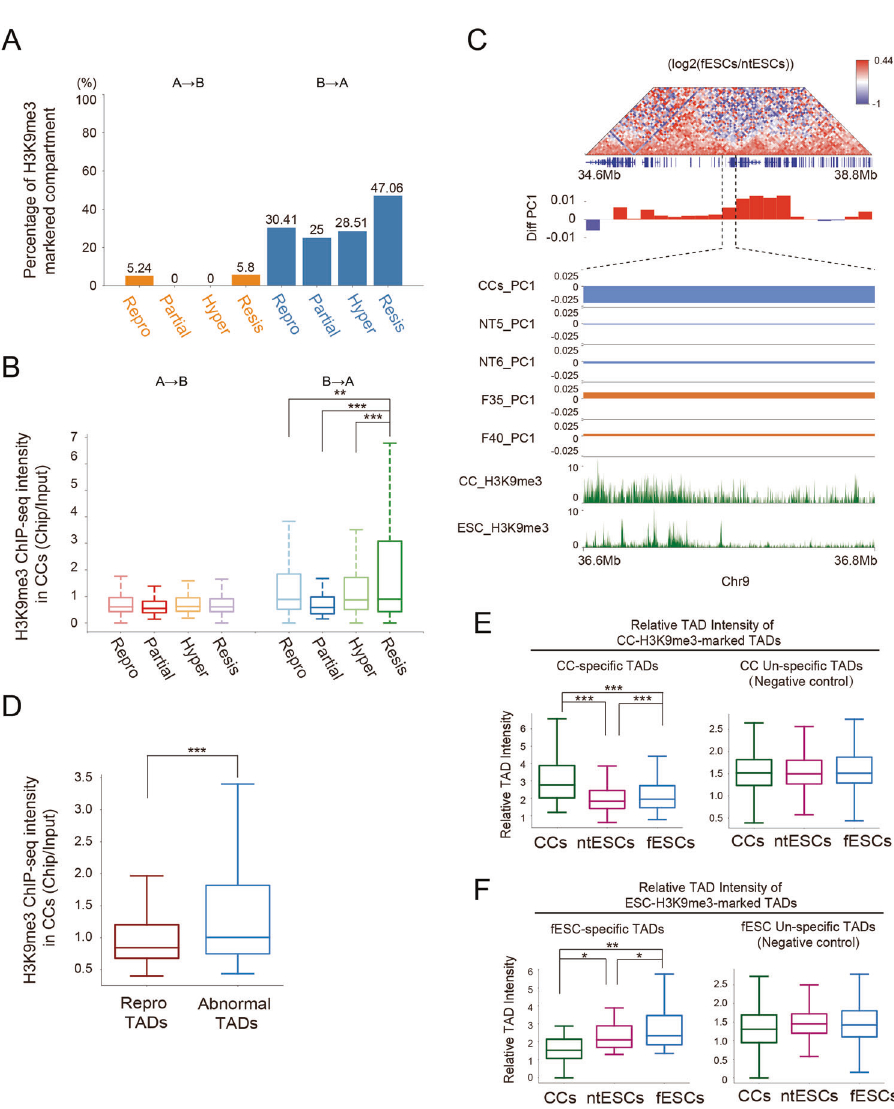
Fig. 6 H3K9me3 in Abnormal chromatin structures in ntESCs. A The bar chart showing the proportion of the H3K9me3-marked compartments in each group in Fig. 4A. B Boxplot showing the average H3K9me3 Chip-seq intensity (Chip/Input) in CCs for each group of compartment dynamics (200 Kb resolution). C The differential interaction frequencies (log2(fESCs/ntESCs)) and corresponding H3K9me3 signals around a B-to-A resistant compartment region. The bottom tracks show the H3K9me3 signals in CCs [18] and ESC [58] respectively within a B-to-A resistant region (Chr9: 36.6 Mb – 36.8 Mb). D Boxplot showing the average Chip-seq intensity (Chip/Input) of H3K9me3 in CCs for the ‘ Repro ’ and ‘ Abnormal ’ TADs (including ‘ Resis ’ and ‘ Hyper ’ ). E Boxplot showing the average relative TAD intensity (RTI) of the H3K9me3-marked CC-speci fi c TADs. The CC-unspeci fi c TADs are also shown as control. F Boxplot showing the average relative TAD intensity (RTI) of the H3K9me3-marked ESC-speci fi c TADs. The ESC-unspeci fi c TADs are also shown as control. Statistical analysis was performed by using the Wilcoxon rank-sum statistic test. *** P < = 0.0005, ** 0.0005 < P value < = 0.005, and * 0.005 < P < =